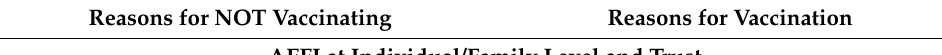
Table 14. Description of theme knowledge and awareness with